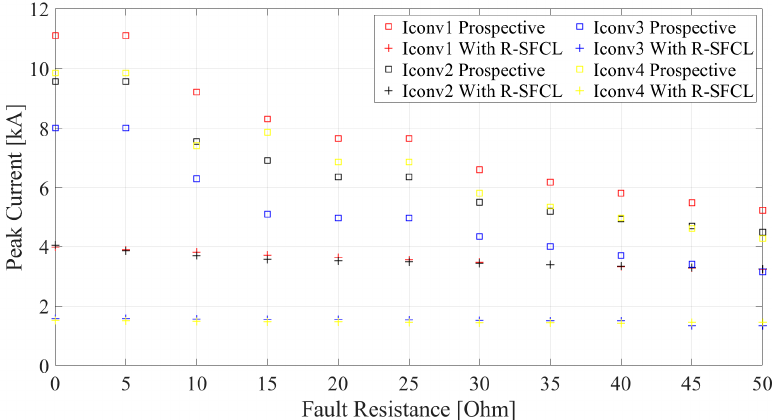
Figure 21. Prospective and limited converter fault peak currents for fault resistance swept between 0 and 50 Ω .